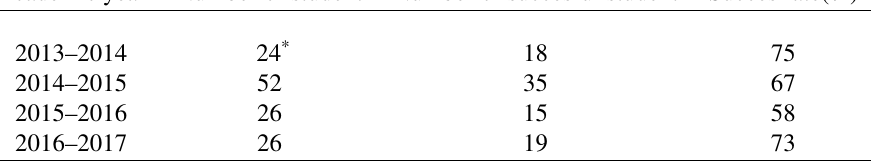
Table 2. The four-year numerical data about Astrobiology